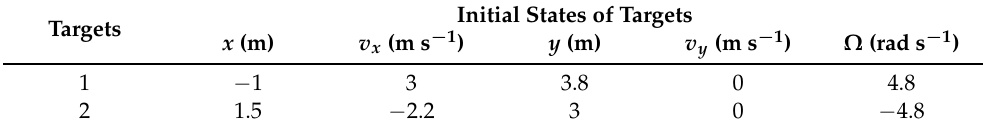
Figure 7. The radar and targets geometry for scenario 2. Table 2. Scenario